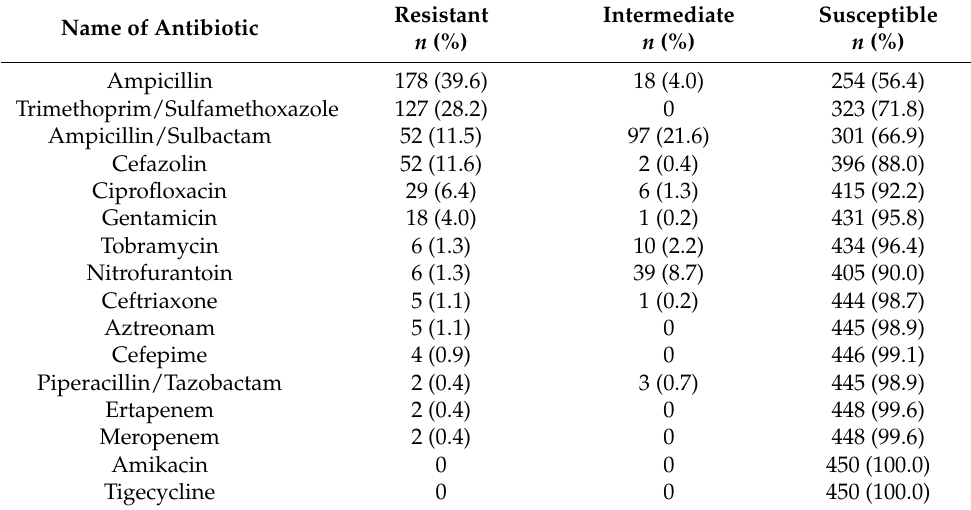
Table 2. Antibiogram of E. coli isolates ( n = 450) displaying specific phenotype profile (resistant, intermediate, or susceptible) against 16 types of antibiotics.